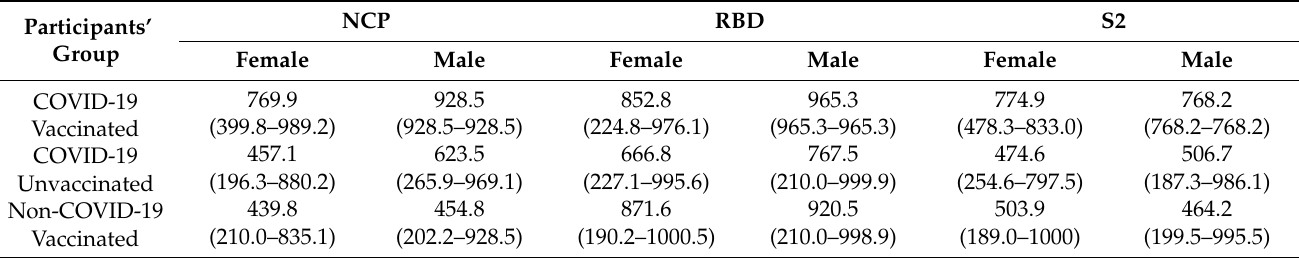
Table 4. The level of NCP, RBD, and S2 (U/mL) in the studied groups by sex 1